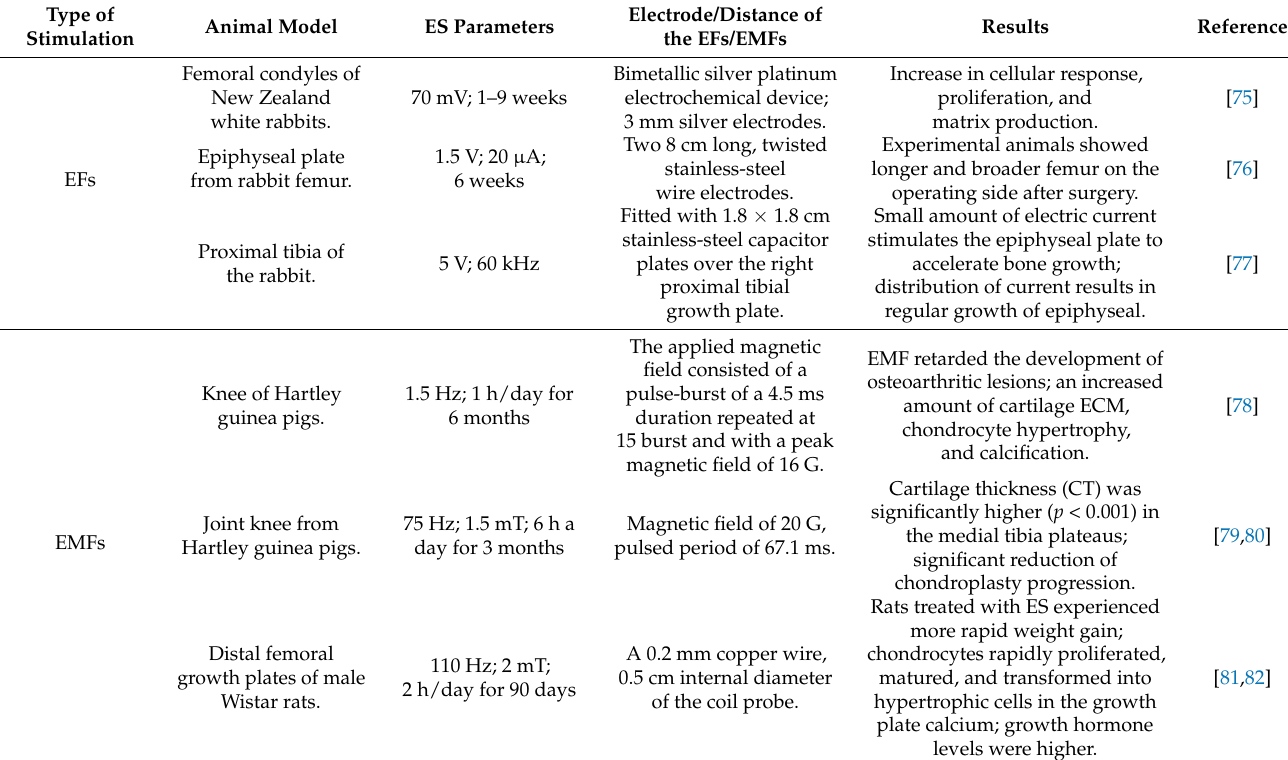
Table 1. ES promotes the in vivo repair of articular